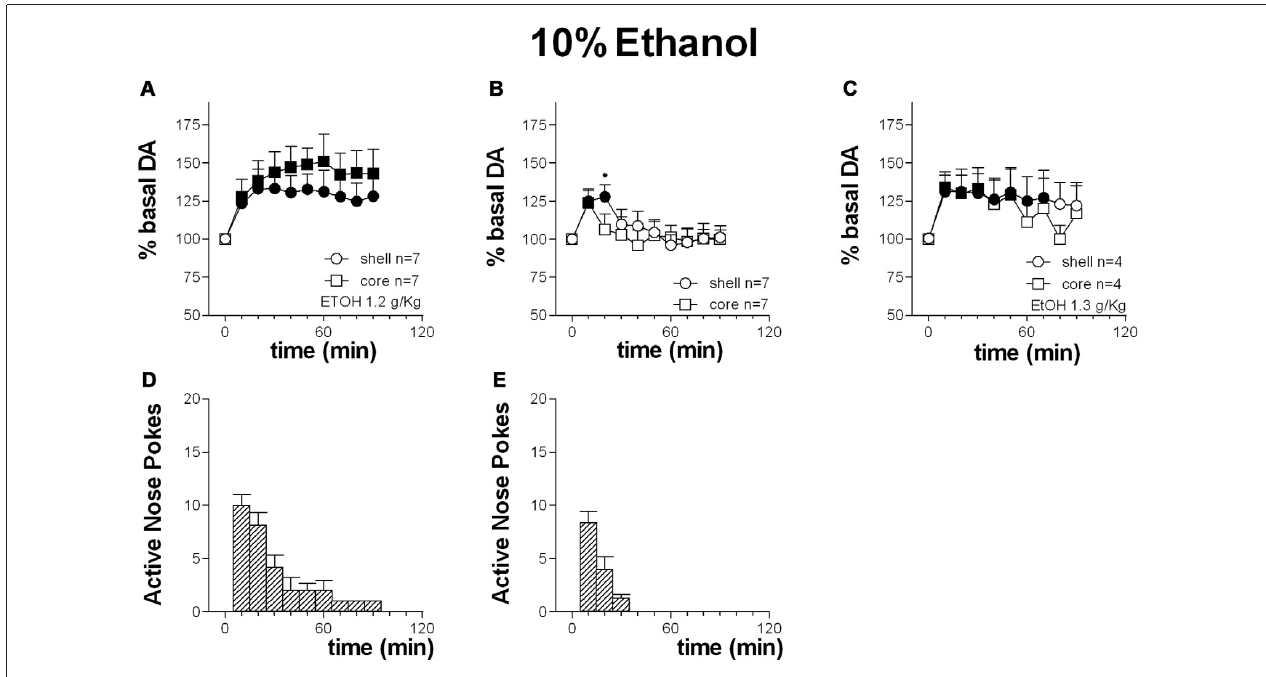
FIGURE 10 | Time-course of dialysate DA in the NAc shell (circles) and core (squares) and active nose pokes (Bars) every 10 min under FR1 responding for 10% ethanol solution (A,D) , extinction (B,E) and non-contingent 10% ethanol solution presentation (C) . Data are means ± SEM of the results, expressed as % of basal values, obtained in the number ( N ) of rats indicated in the figure. Filled symbols: p < 0.05 vs. basal values; ∗ p < 0.05 vs. values obtained in the